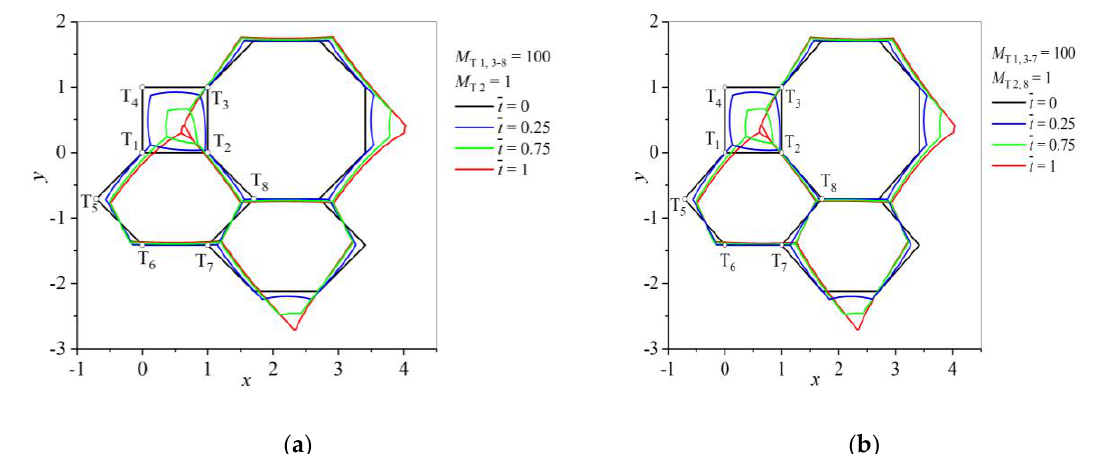
Figure 7. Evolution of the grain arrangement for different normalized times t . ( a ) Case III: The